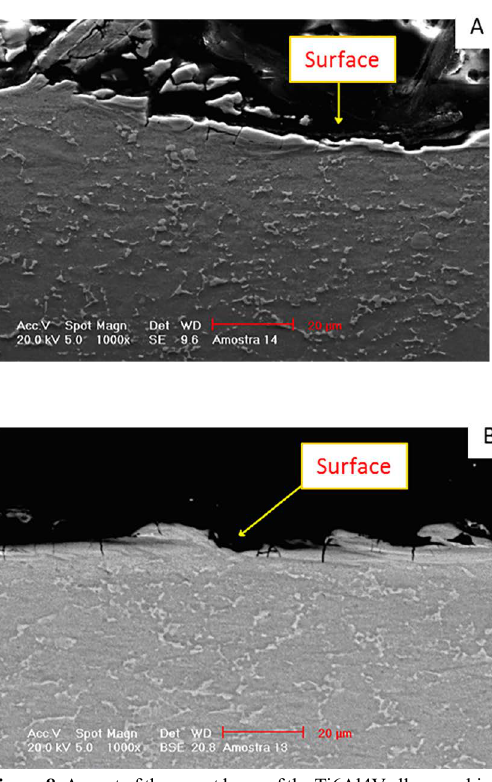
Figure 8. Aspect of the recast layer of the Ti6Al4V alloy machined by the WEDM process with a zinc-coated copper wire, using interval time t of (A) 13.2 µs and (B) 23.2 o